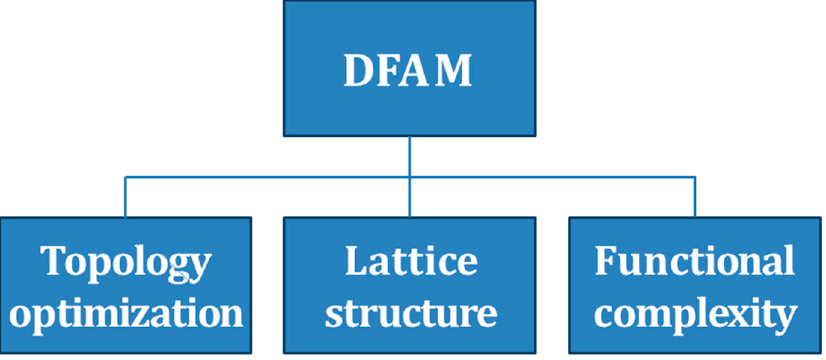
Figure 16. Design for additive manufacturing .